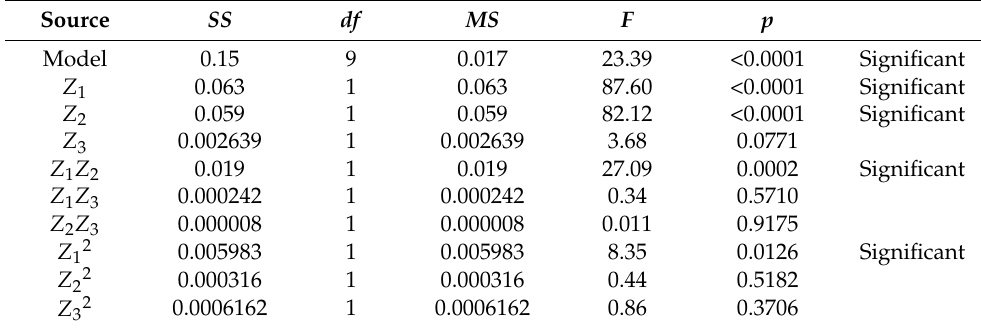
Table 7. Analysis of variance for response y